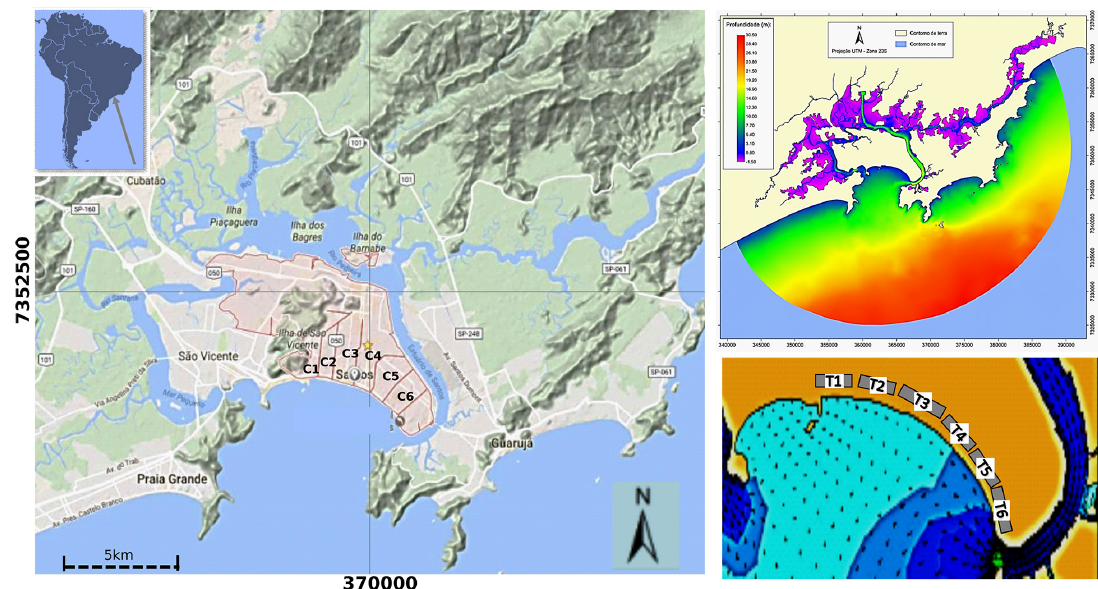
Fig. 1. Study area, with geomorphological, bathymetric, and drainage details and the location of the sample transects (T1–T6) on Santos